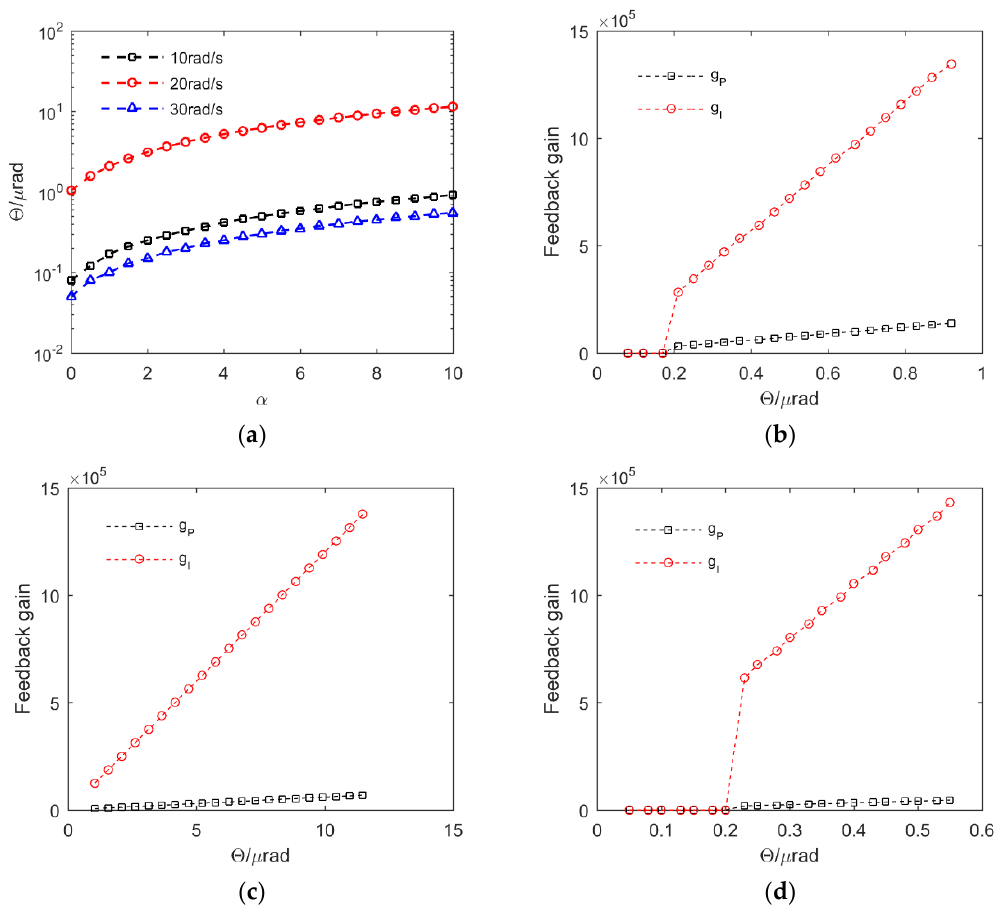
Figure 15. The corresponding relationship between the parameters of the pointing threshold and the amplitude of the output light angle response when the phase difference ∆ ϕ = π is less than 0.2 µ rad: ( a ) The corresponding relationship between the ratio of the excitation amplitude and the peak value of the output light angle response when the excitation frequency changes from low frequency to high frequency; ( b ) the corresponding relationship between the active feedback gain and the peak value of the output light angle response of the Optomechanical system with 10 rad/s excitation frequency; ( c ) the corresponding relationship between the active feedback gain and the peak value of the output light angle response of the Optomechanical system with 20 rad/s excitation frequency; ( d ) the corresponding relationship between the active feedback gain and the peak value of the output light angle response of the Optomechanical system under the 30 rad/s excitation frequency.